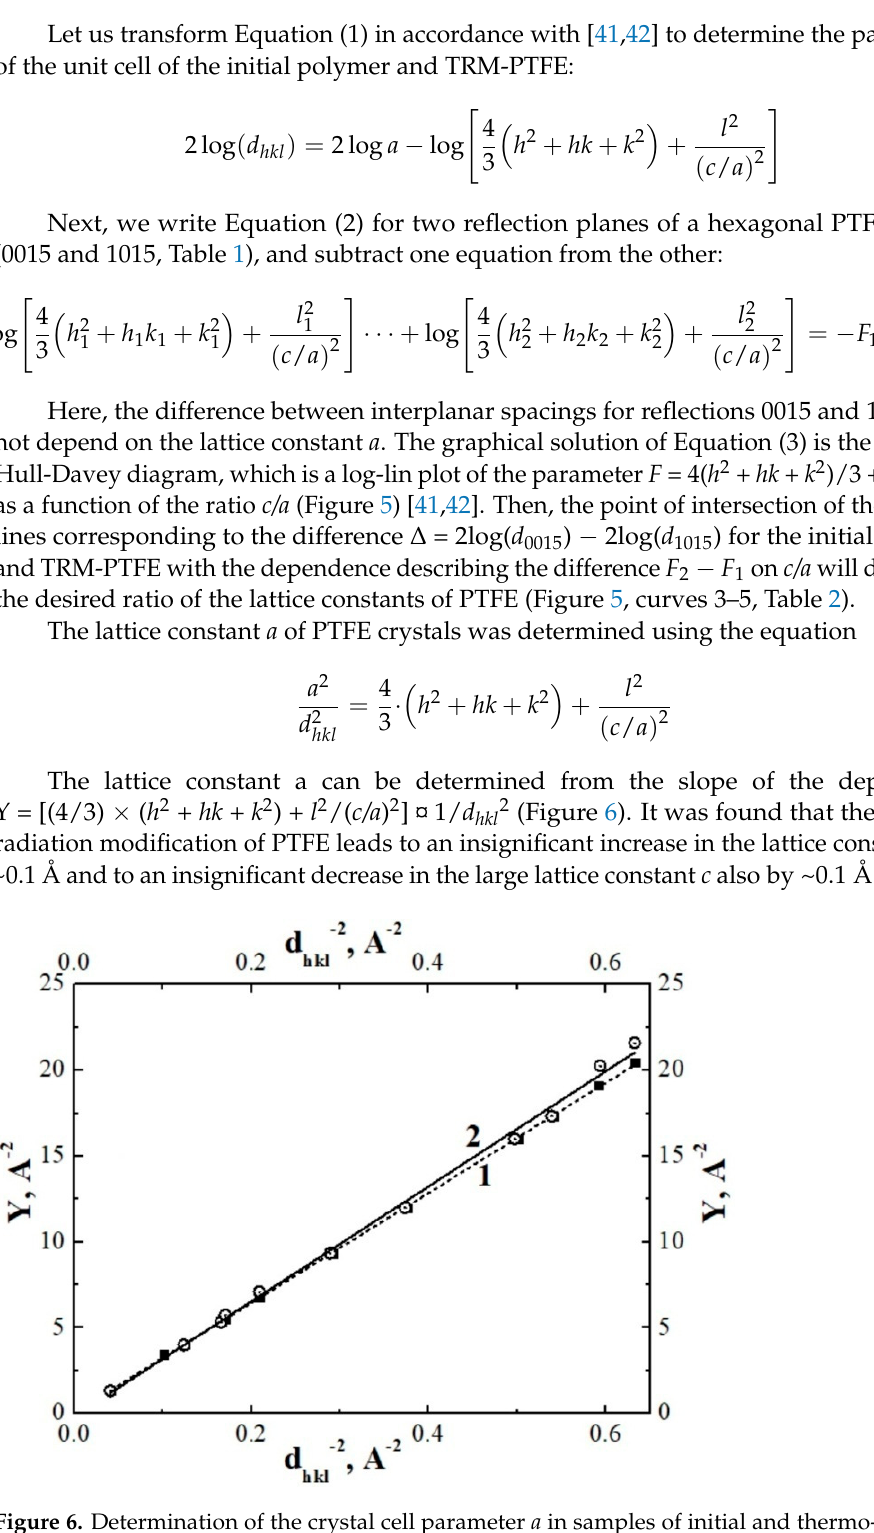
Figure 6. Determination of the crystal cell parameter a in samples of initial and thermo-radiation- modified polytetrafluoroethylene (dependences 1, 2, respectively). Linear dependences 1 and 2 are obtained by the least-squares method.